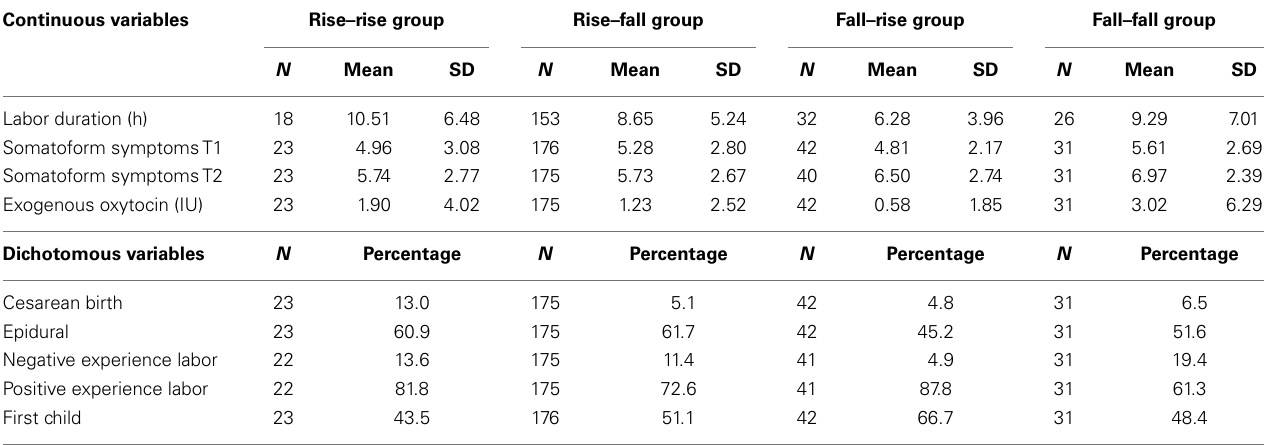
Table 2 | Descriptive statistics for each group of women according to their pattern of oxytocin level variation